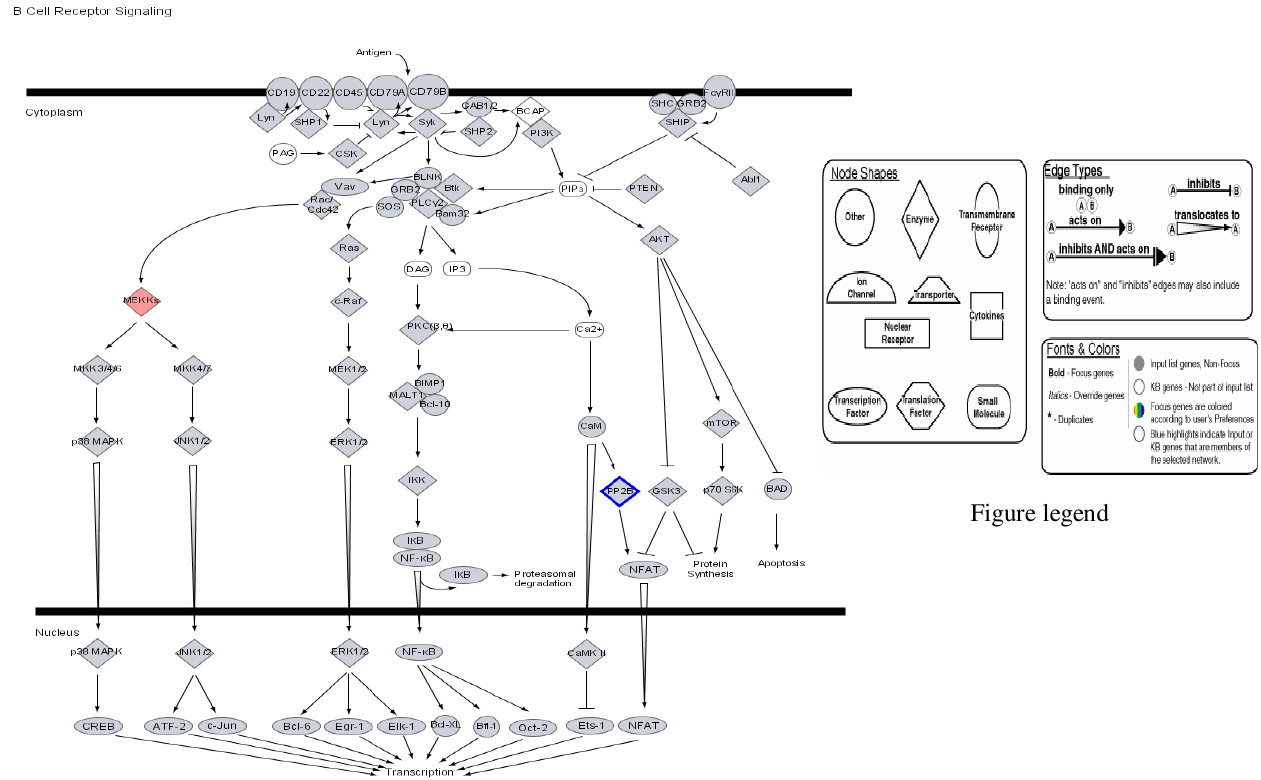
Figure 2: Modulation of B cell cycle receptor signalling by mercury : Activation of MEKK and repression of PF 2B.